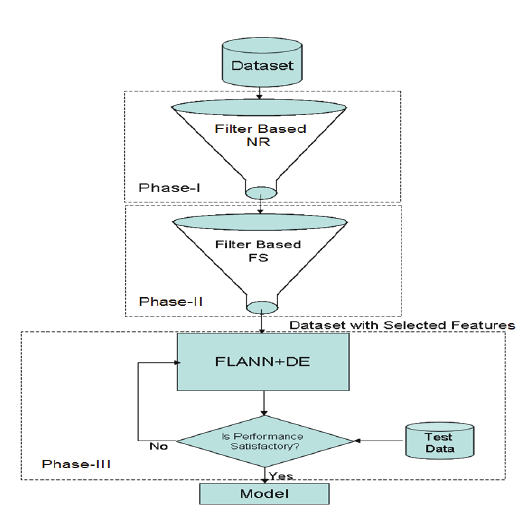
Figure 2: Architecture of Proposed Method